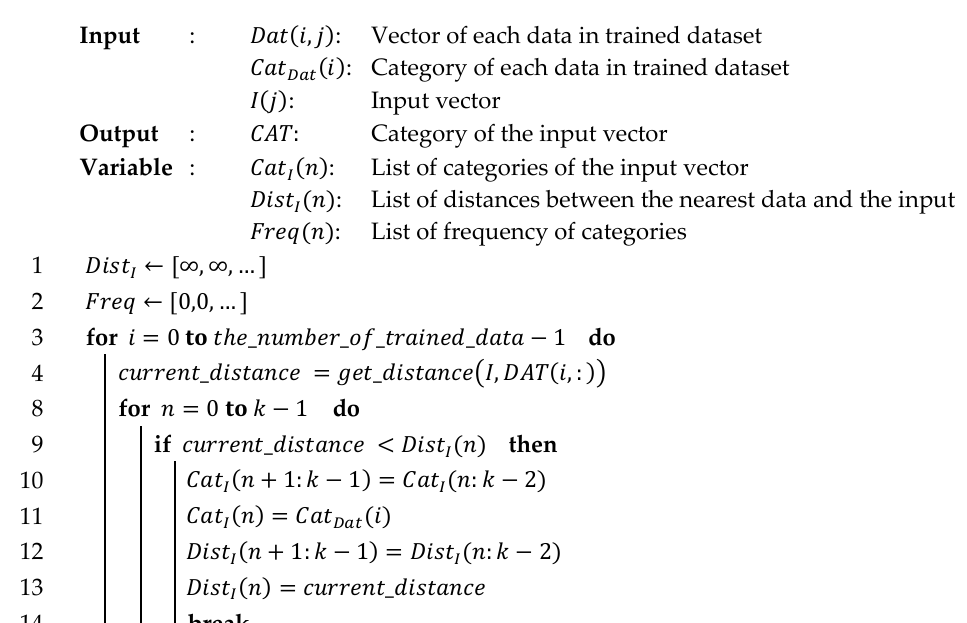
Algorithm 1: k -NN classification algorithm pseudo-code